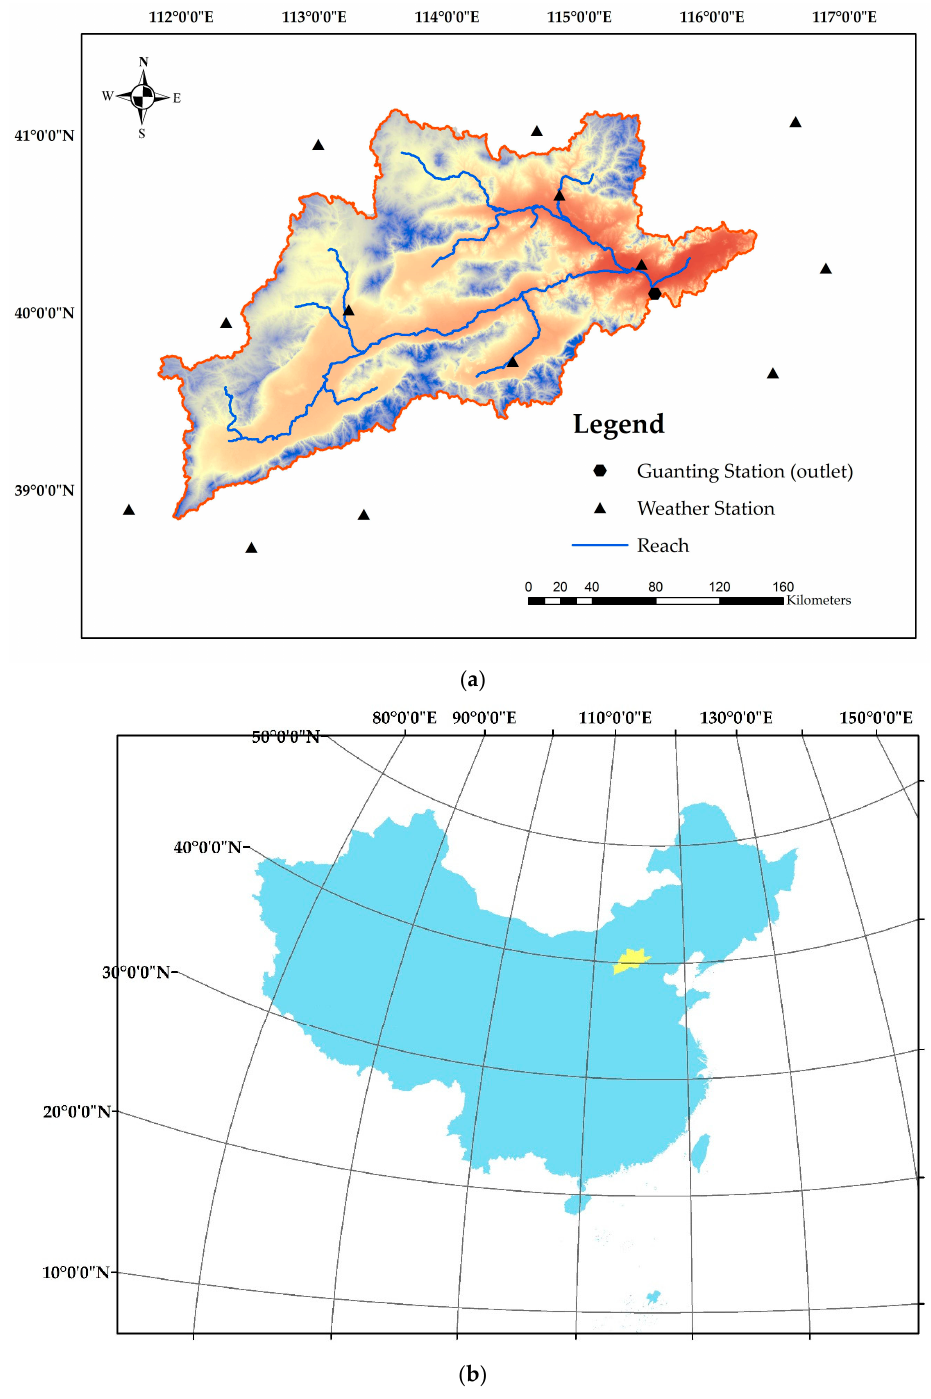
Figure 1. The location of the study area. ( a ) The location of the river system and weather stations in study area and ( b ) The location of study area in China.